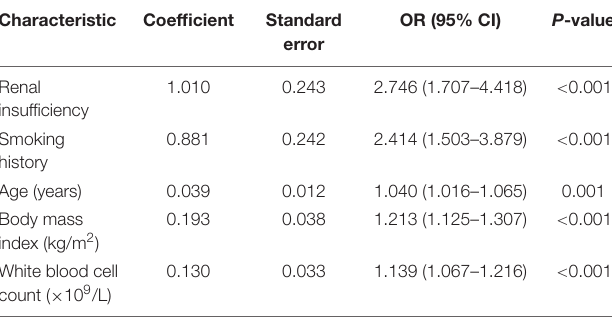
TABLE 2 | Multivariate analysis of independent risk factors for severe hypoxemia after AADS.